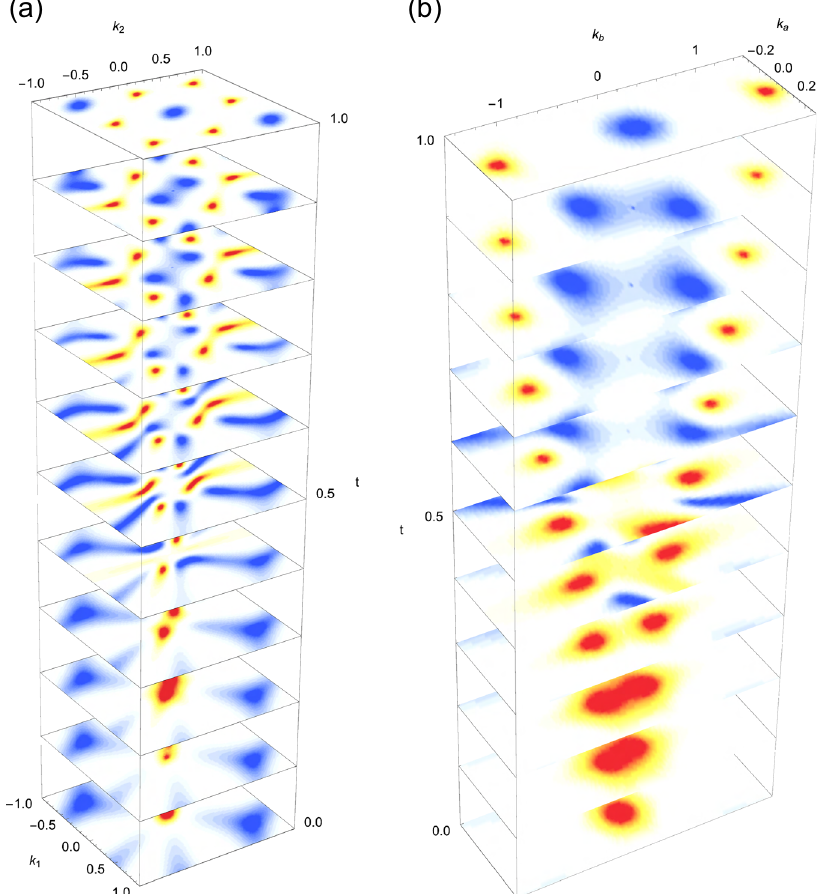
Fig. 7 Braiding patterns via C 6 symmetry breaking. Braiding within a three-band model of the group 1 of bands (see Fig. 2 in the main text) with broken C 6 symmetry a over the entire Brillouin zone ( k 1 , k 2 )/ π ∈ [ − 1, 1] 2 , and b zooming around the Γ point. The red (blue) density plot corresponds to the nodes of gap 11 (gap 10), and the vertical axis t ∈ [0, 1] corresponds to the electric fi eld from 0 eV/ Å to 1.8 eV/ Å . See Fig. 8 showing the detailed transfer of charge due to the braiding in the vicinity of Γ .